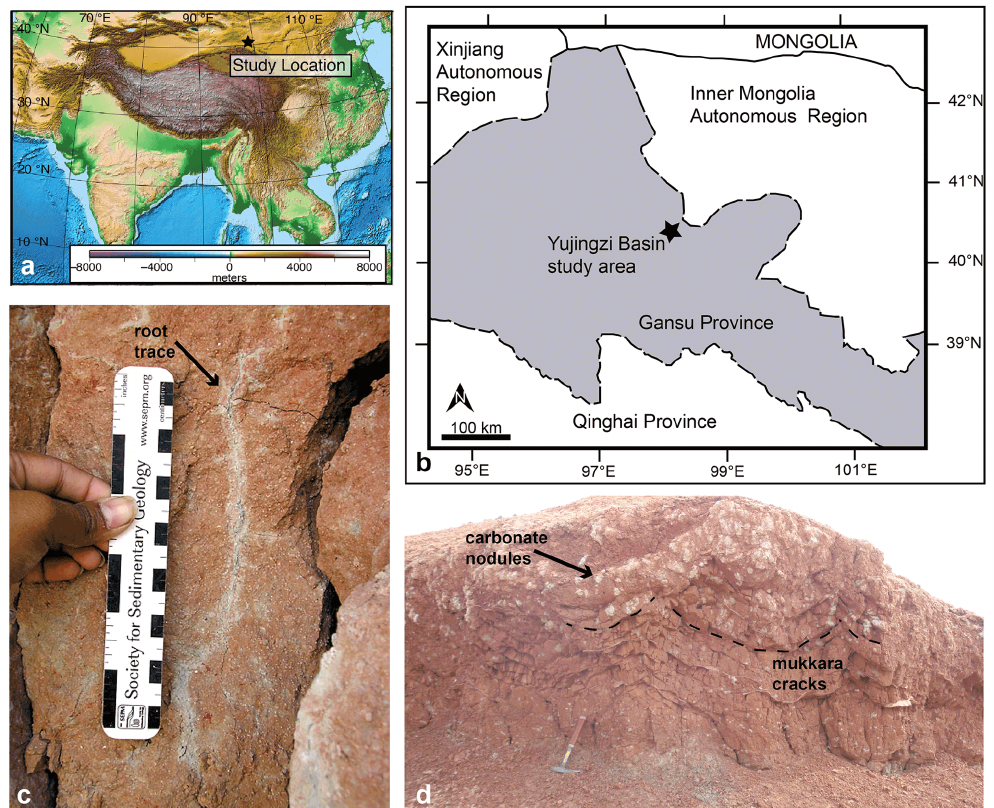
Figure 1. Approximate location of sampled sections with respect to regional topography ( a ; Amante and Eakins, 2009) and geography (b) . Outcrop images of carbonate nodule bearing Vertisol section typical of the composite study section (c, d) . Root traces, mukkara cracks, ped structure and coloration (Retallack, 1997) are all indicative of